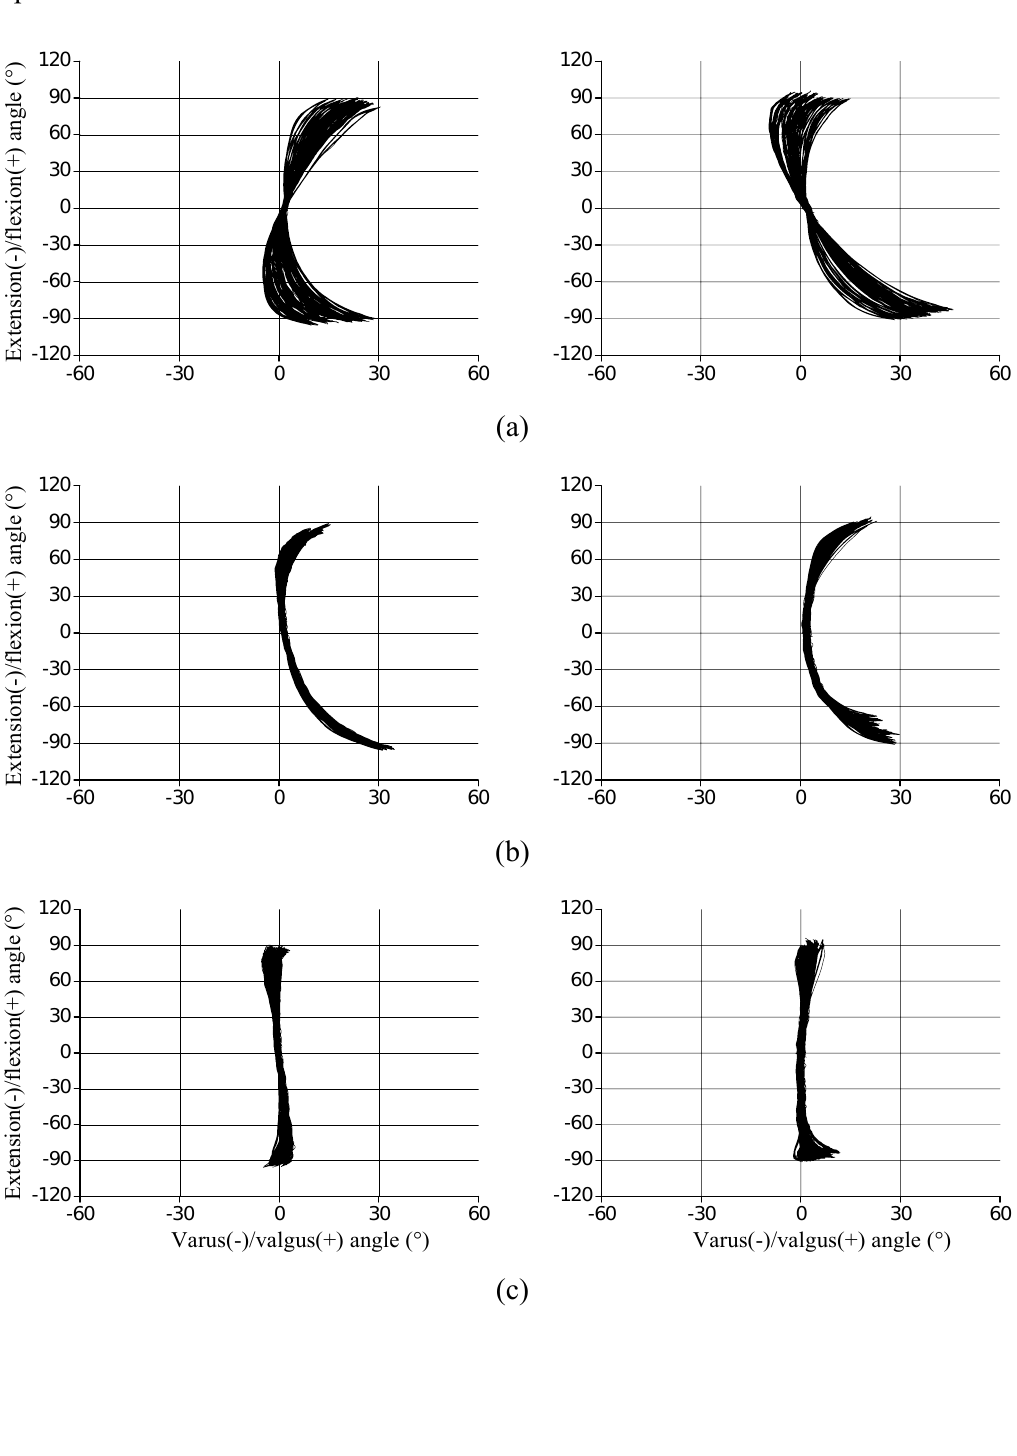
Figure 6. X-Y plots of valgus/varus and flexion/extension angles for internal rotation (left graphs) and external rotation (right graphs) misalignments from 2° to 30° in steps of 2° (15 trials). For each trial about 15 movements of ±100° pure flexion/extension were performed. (a) Raw data; (b) General crosstalk compensated data; (c) General and individual crosstalk compensated